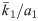
Effect of channeling on reaction cascades with competing reactions.(a) Product formation velocity of the nonchanneled system, vnon, decreases as the degradation or consumption rate of intermediates, kdeg, increases. (b) Reaction velocity of the nonchanneled system falls off for increasing ‘degree of reversibility’ of the first reaction in the cascade, k¯1/a1. In this case the reaction is S+E1⇌d1a1SE1⇀↽k¯1k1E1+I in lieu of Eq (1a). In both plots vnon is compared to the velocity of the channeled system, vch. The concentrations of enzymes and enzyme-enzyme complexes are equal in both systems on both panels, i.e. [Ei] = [E1] = [E2] = [E12]; in panel (b) the ratio vnon/vch is independent of [Ei]. Substrate concentration [S] = 90 nM, the degree of diffusion control is γ1 = γch = 1 (see Eq (10)), and the rate constants are the same as in Fig 1. Thin dotted line denotes vch = vnon.